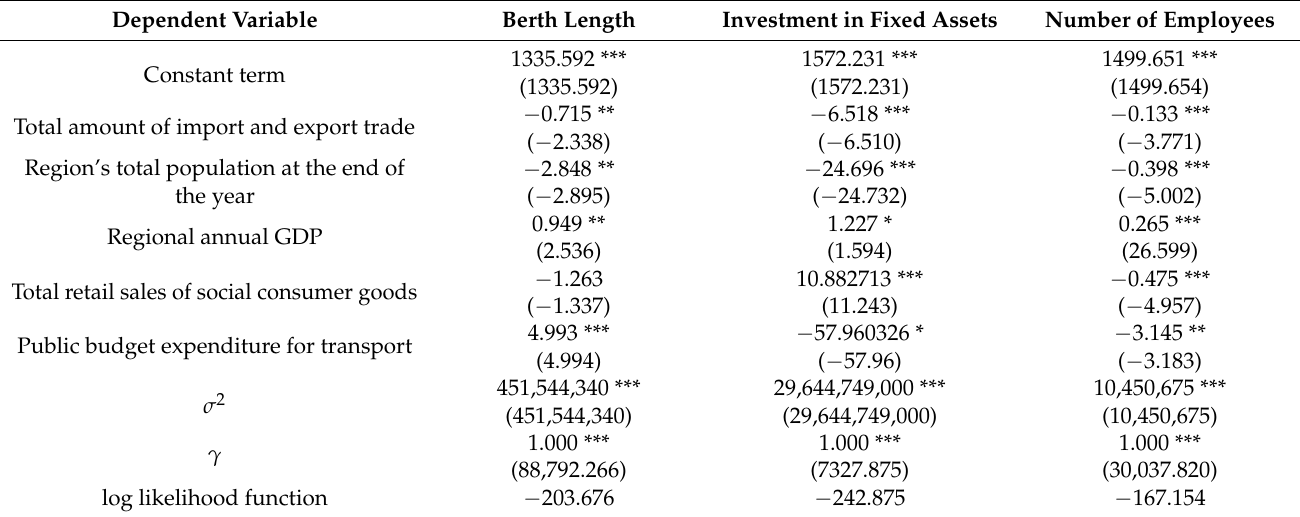
Table 3. The results of the second stage SFA